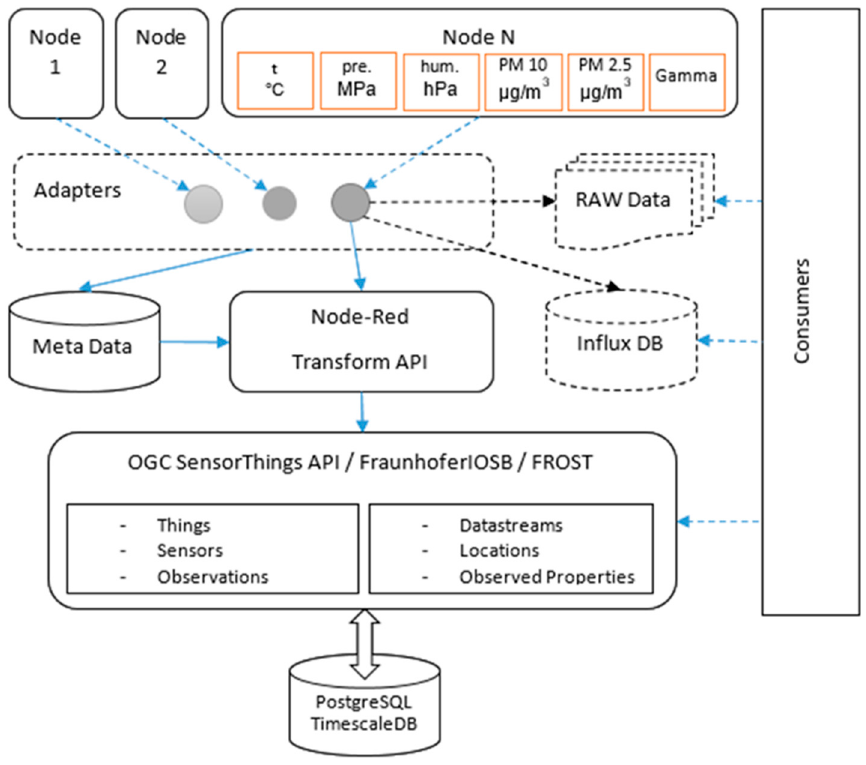
Figure 8. Architecture of the regional data center.